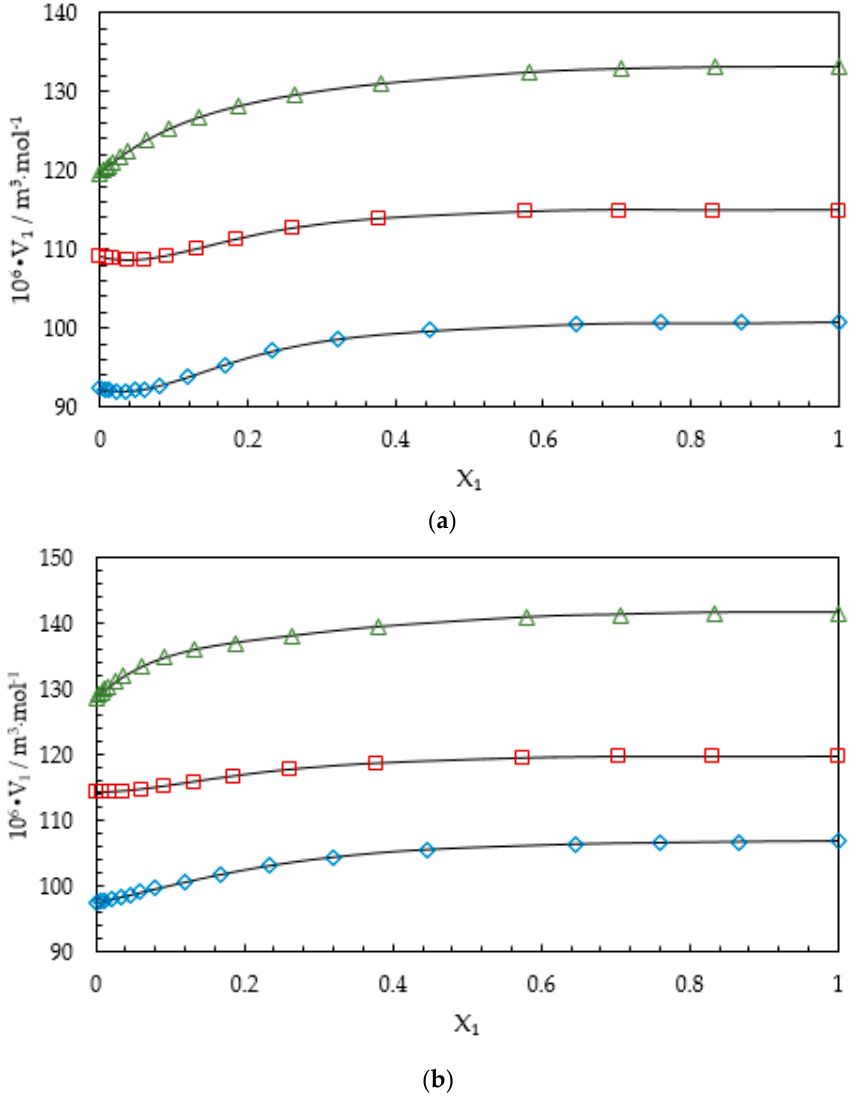
Figure 2. ( a ) Partial molar volumes of MDEA in (MDEA + H 2 O), ‘ □ ’; DMEA in (DMEA + H 2 O), ‘ ◊ ’